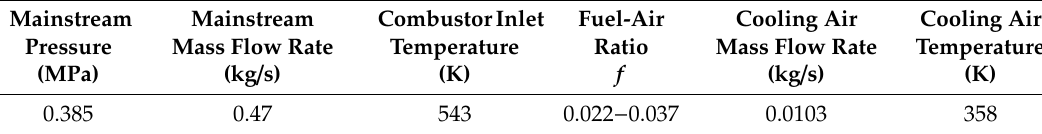
Figure 11. Temperature distribution at the test section inlet (combustor outlet). Table 1. Main operating parameters of the test facility.